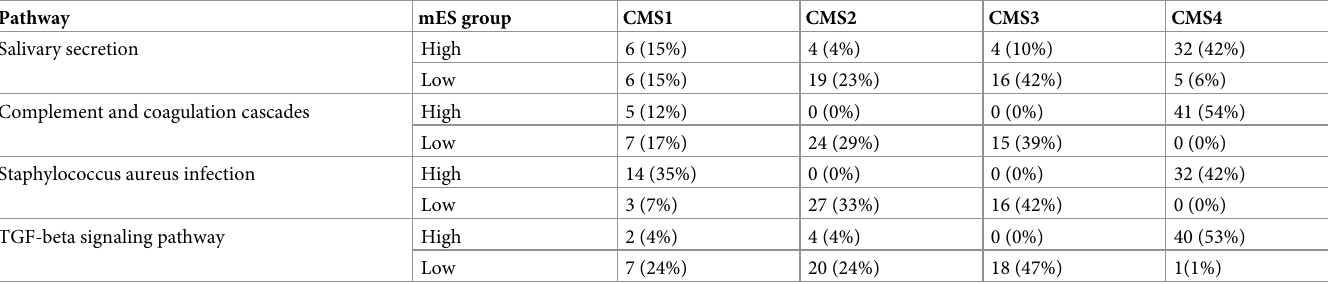
Table 5. Percentage of COAD samples belonging to high and low mES groups.